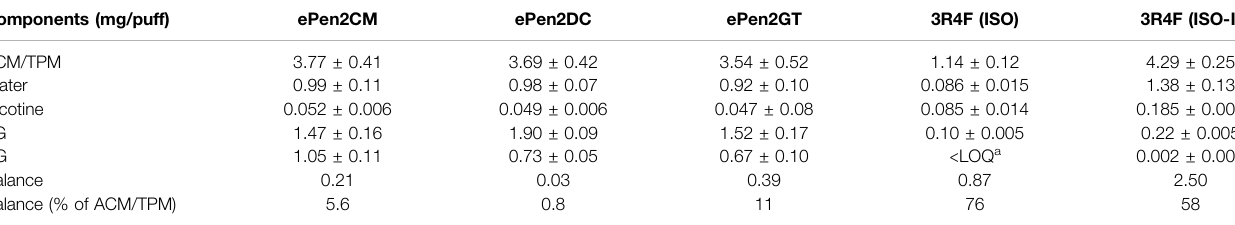
TABLE 4 | Comparison of total quantities of cigarette smoke (3R4F) and aerosol (ePen2), and their major smoke/aerosol components. Components (mg/puff)